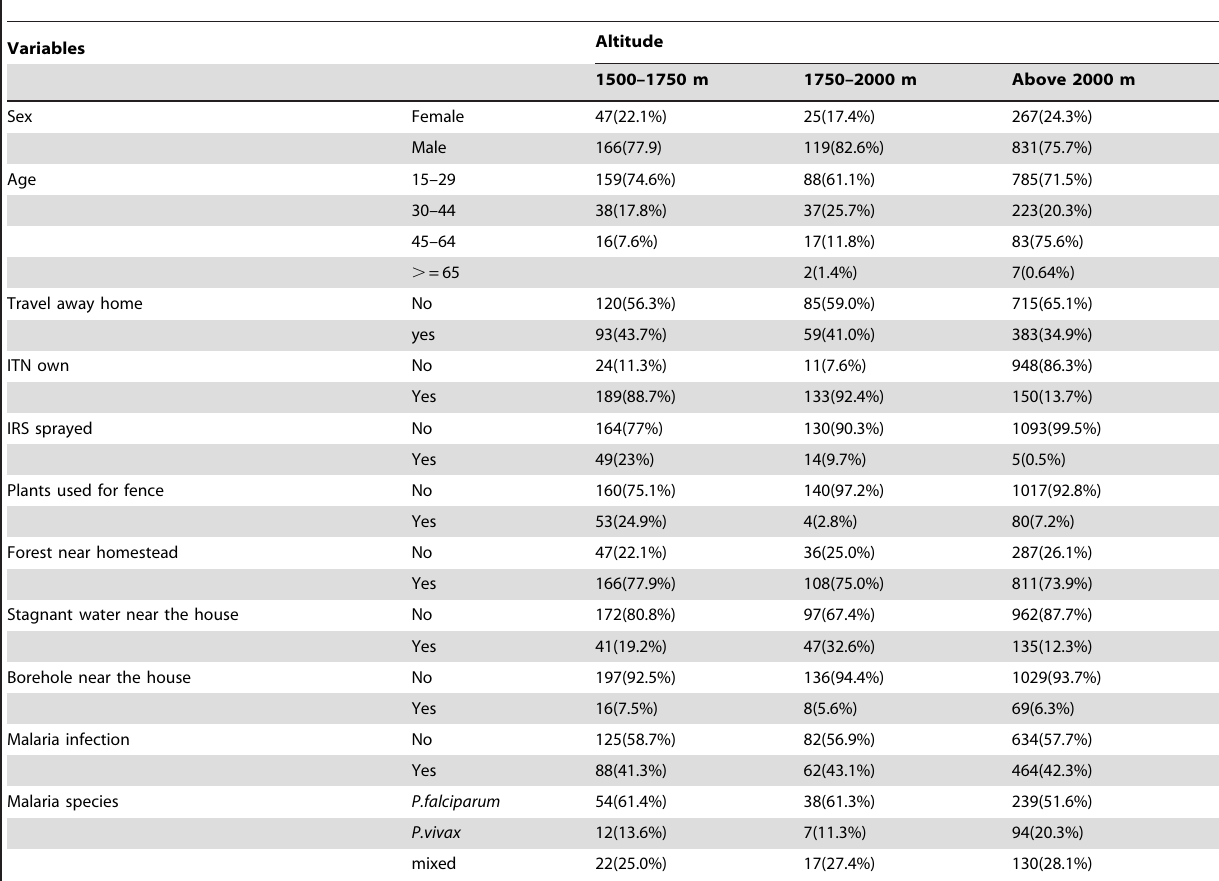
Table 3. Characteristics of malaria risk factors by altitude in highland villages, northwest Ethiopia, 2013.